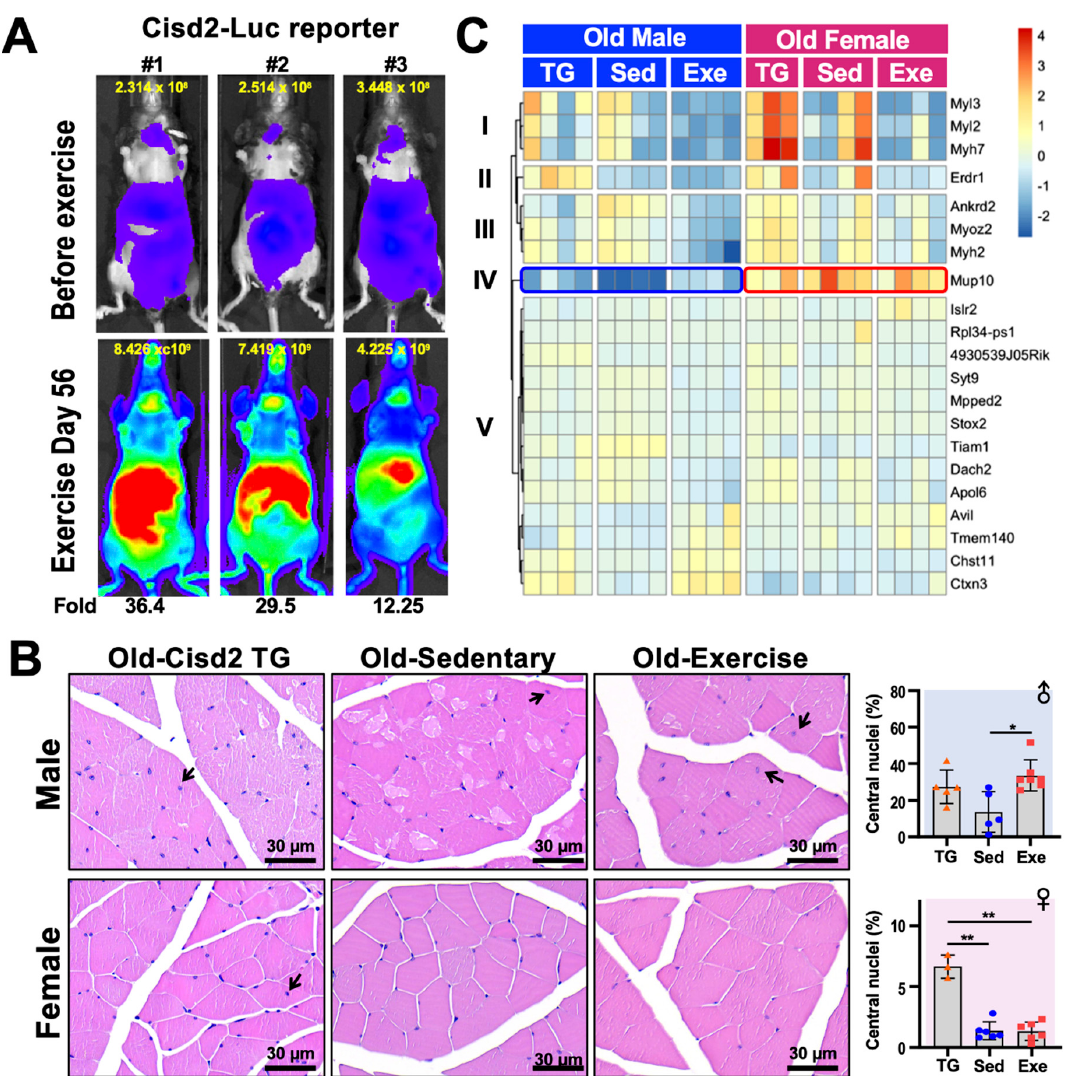
Figure 2. Histology and transcription analysis of femoris muscle from mice that have practiced long-term exercise. ( A ) Luciferase activity in Cisd2-Luc reporter mice before and after 56-days of treadmill exercise. The treadmill protocol was 6 m / min for 5 min, 9 m / min for 5 min, 12 m / min for 20 min, 15 m / day for 5 min and 12 m / day for 5 min, for a total of 450 m / day. The Cisd2-Luc reporter mice ran on treadmills at a frequency of 5 days / week for 8 weeks (56 days). The quantification of luciferase intensity in each of the mice in the figure is shown at top of each image. Increased (fold change) Cisd2-Luc luciferase signals are numbered below the images; these represent mice after the exercise was completed. The photos were taken ventrally. ( B ) H&E staining of the femoris muscles of Cisd2-TG, Old-Sed and Old-Exe male and female mice. The arrows indicate myofibers that contain central nuclei. Bars: 30 µ m. Percentage of central nucleation in each group of mice is presented on the right. The data are presented as means ± SD. Statistical analysis used the Student’s t-test. *, p < 0.05; **, p < 0.01. TG, Cisd2-TG; Sed, sedentary; Exe, exercise. ( C ) A heatmap showed the differentially expressed gene (RNA-Seq) clusters for the male and female femoris muscle that have been changed by long-term treadmill exercise. The RNA-seq data was analyzed by “DEseq2” and the DE genes were defined as LFC > 0.14 and FDR < 0.1. The heatmap was generated using the “pheatmap” R package (Raivo Kolde (2019). pheatmap: Pretty Heatmaps. R package version 1.0.12. https: // CRAN.R-project.org / package = pheatmap) according to rlog transformed count calculated by